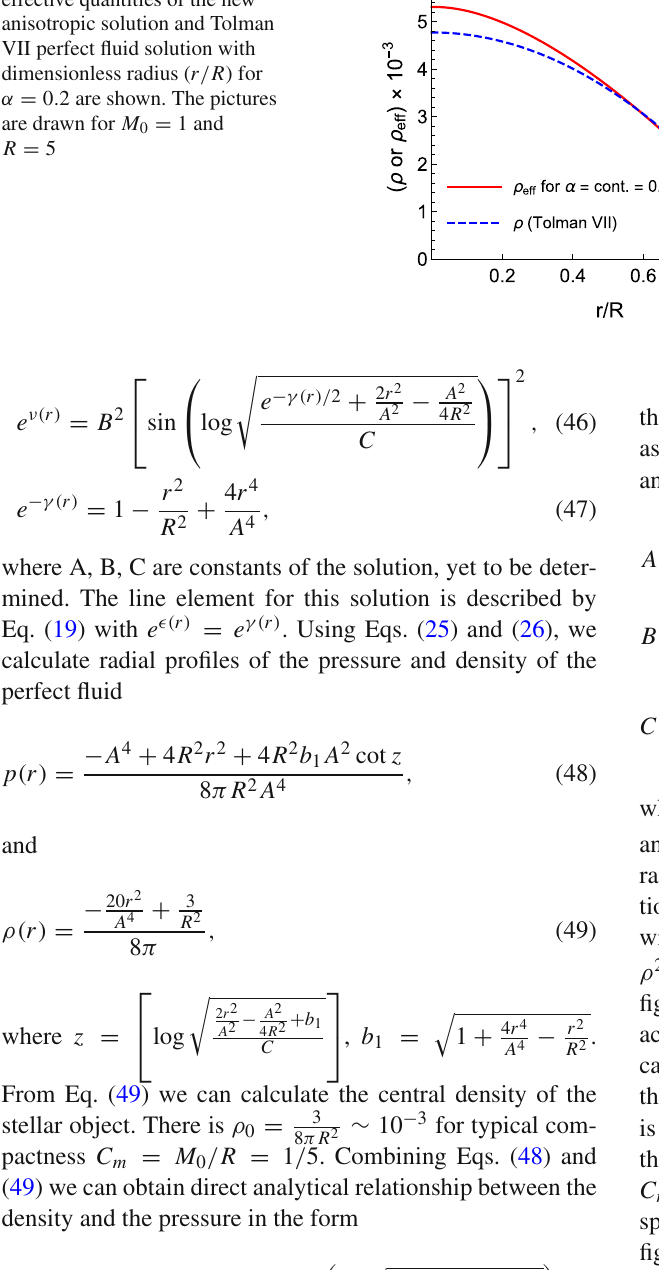
Fig. 1 The dependence of the effective quantities of the new anisotropic solution and Tolman VII perfect fluid solution with dimensionless radius ( r / R ) for α = 0 . 2 are shown. The pictures are drawn for M 0 = 1 and R =